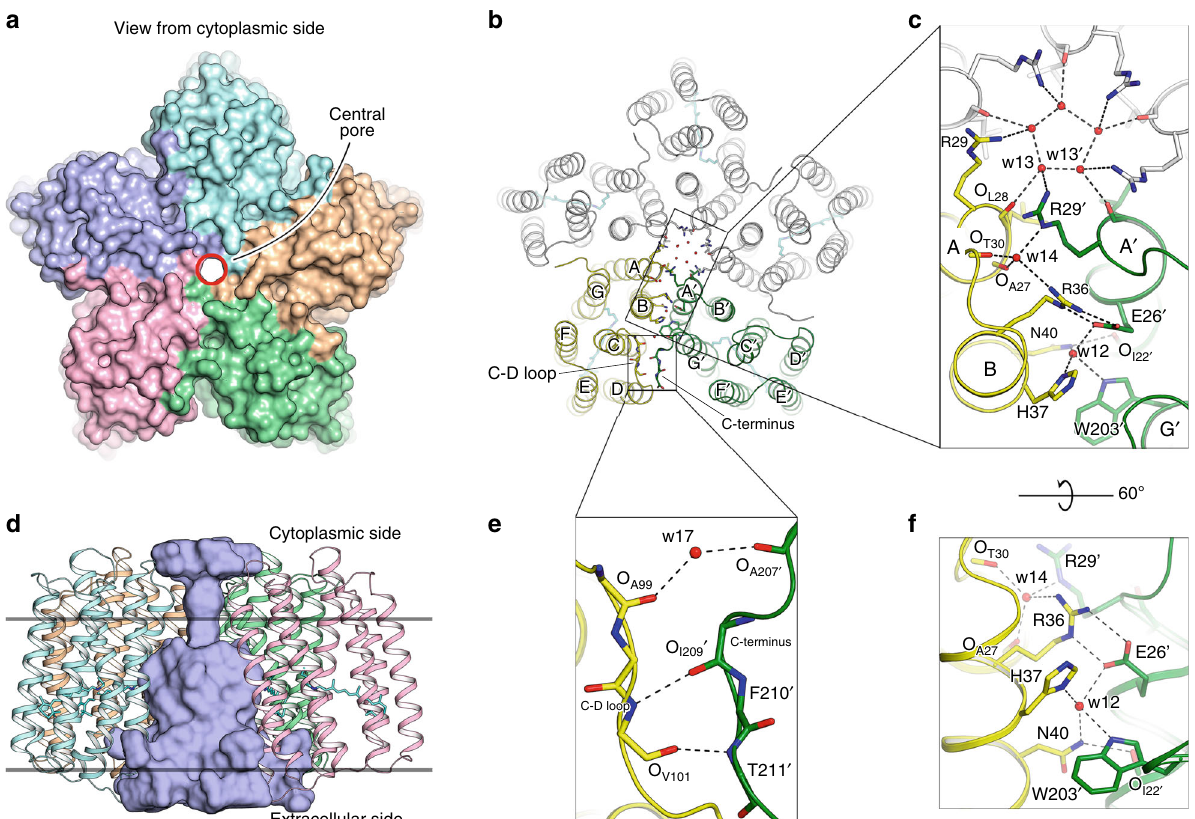
Fig. 1 Architecture of OLPVRII pentamer and interprotomer contacts. a View from the cytoplasmic side. Surface representation of the pentamer. Central pore is contoured by a red circle. b View from the cytoplasmic side. Cartoon representation of the pentamer. Retinal cofactor is colored cyan. c Detailed view of the main region of interprotomer contacts. Protomers C, D and E are colored gray. d Side view of the pentamer. One protomer is hidden for clarity. Cavity inside the pentamer was calculated using HOLLOW 69 and is colored light blue, the hydrophobic membrane core boundaries are shown with solid horizontal lines. e , f Detailed view of the interprotomer